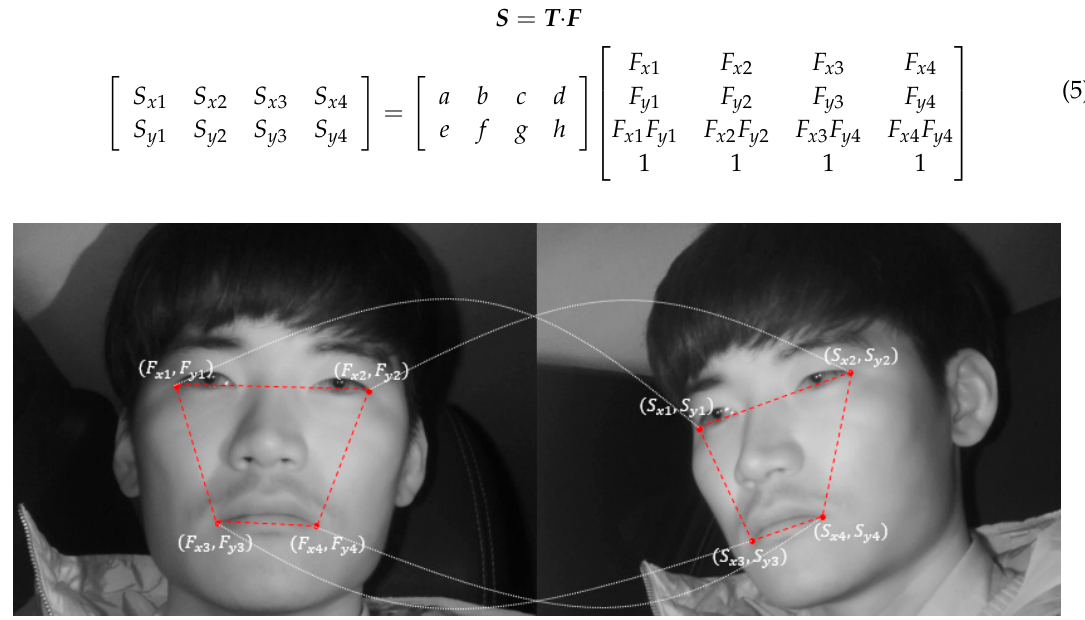
Figure 8. Mapping of eye regions using geometric transform.